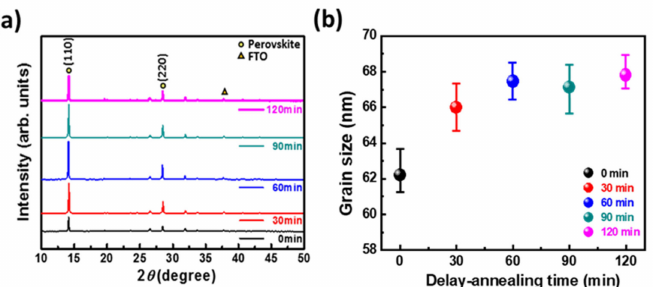
Figure 2. ( a ) XRD of perovskite films prepared with various delay-annealing times. ( b ) Crystallite size of perovskite films.